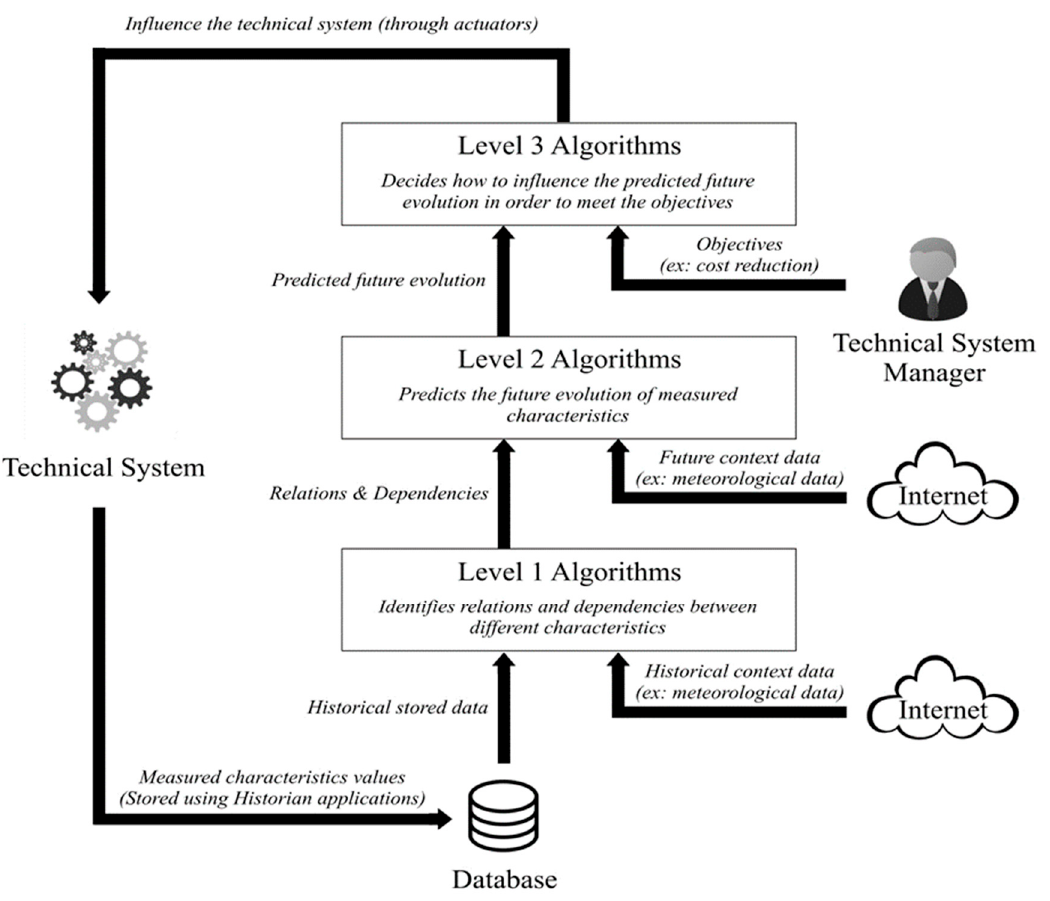
Figure 2. Reference architecture for a proactive Historian